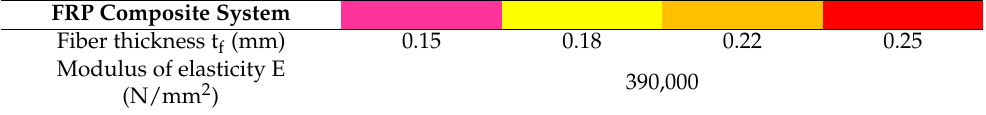
Figure 21. Capacity curves for the model strengthened by FRP composite system for x (blue) and y (red) direction. Table 6. FRP composite system properties.